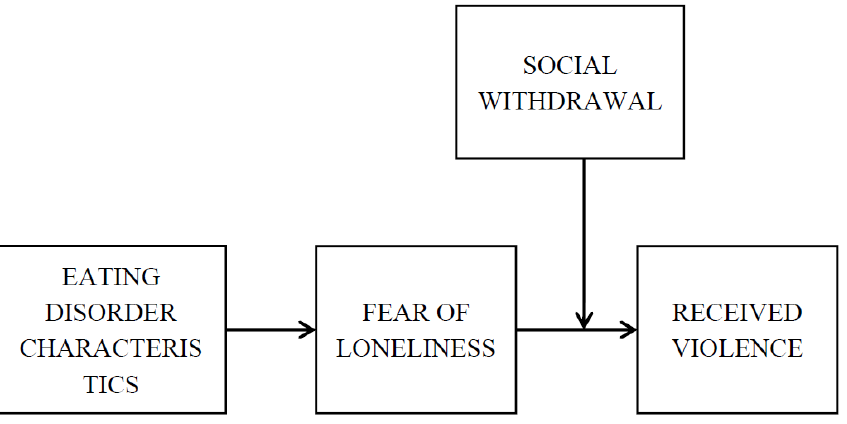
Figure 1. Hypothesised